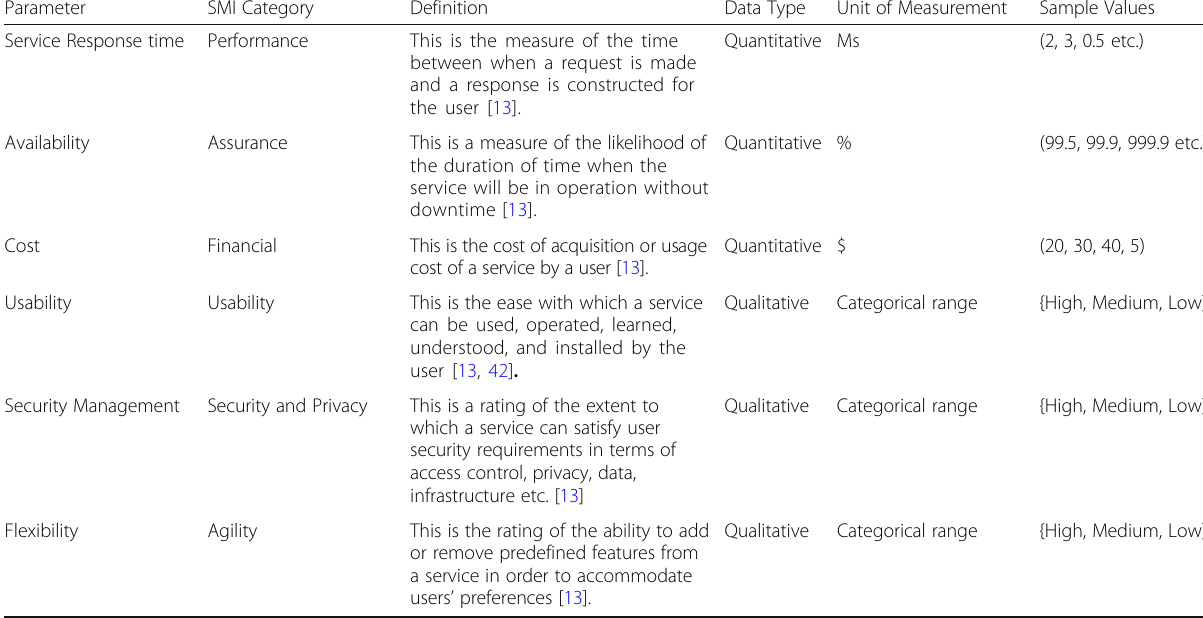
Table 2 Definition and Description of the Six QoS Attributes Parameter SMI